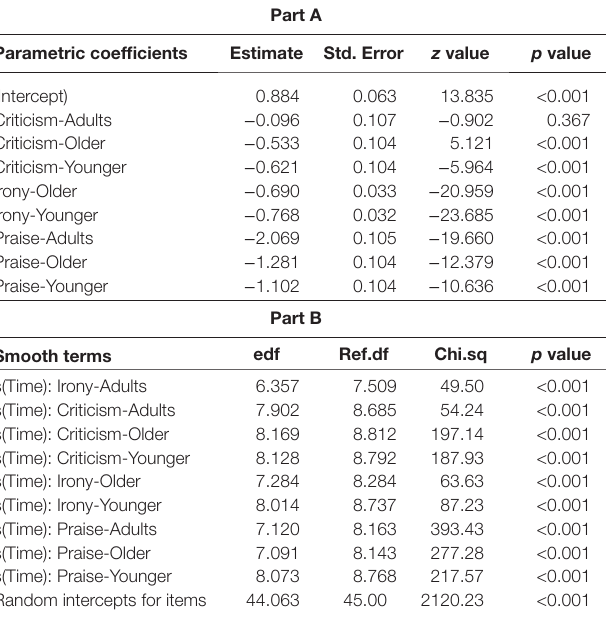
TABLE 3 | Generalized additive mixed model reporting parametric coefficients (Part A), and smooth terms and random effects (Part B). Part A Parametric